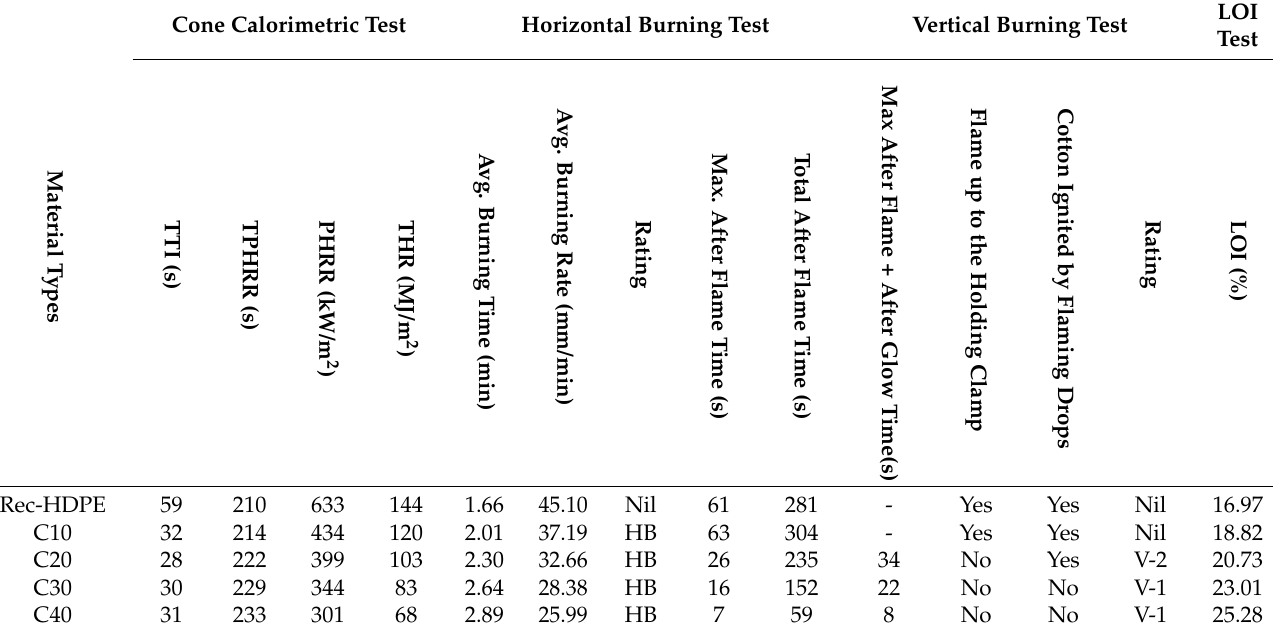
Table 4. Fire retardant properties of the recycled HDPE and